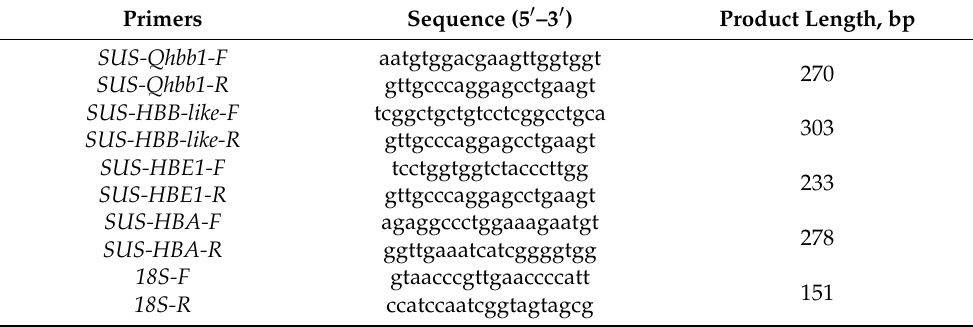
Table 1. HBB gene family primer